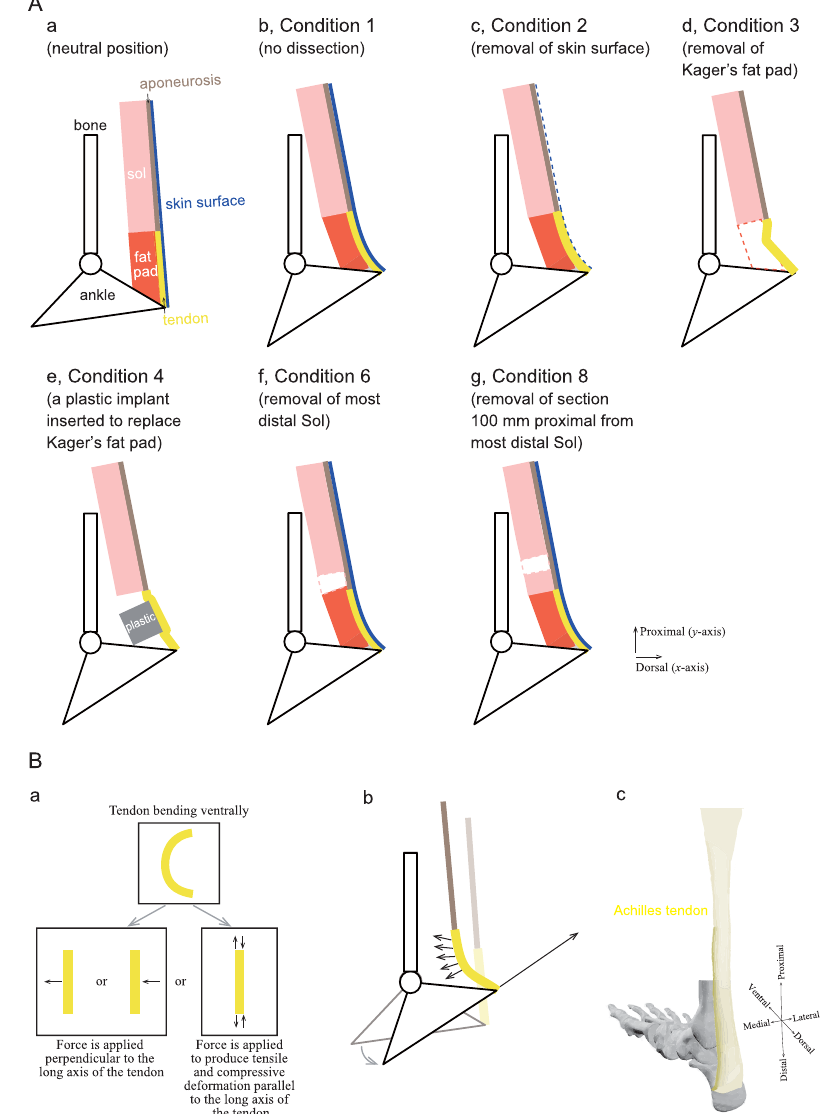
Figure 3. Schematic drawings to illustrate observed tendon bending patterns and a possible mechanism for Achilles tendon bending with passive ankle plantarflexion. ( A ) Diagram representing the observed tendon bending patterns. (a) The ankle is positioned in the neutral position. Red and pink indicate the Kager’s fat pad (fat pad) and soleus (sol) muscle, respectively. The Achilles tendon (tendon) (thick yellow line) is aligned in series with the aponeurosis (light brown line). (b) As the ankle is plantarflexed passively, the Kager’s fat pad constrains tendon movement in the ventral direction, but the skin surface (blue line) also seems to be constrained in the dorsal direction (Condition 1). (c) Even if the skin surface is removed (Condition 2), the magnitude of tendon bending is similar to that of Condition 1. (d), The tendon buckles significantly after removal of the fat pad (Condition 3). (e) Tendon buckling is not observed if a plastic material is implanted in place of the fat pad (Condition 4). (f and g) Removal of the most distal portion of the sol muscle (Condition 6) and the section of the sol muscle 100 mm proximal from the most distal edge of the sol muscle (Condition 8) does not alter the magnitude of tendon bending. ( B ) Schematic illustration of a possible mechanism for Achilles tendon bending. (a) Possible phenomenon of tendon bending in the ventral direction. The tendon will bend if a force is applied perpendicular to the long axis of the tendon or if a force is applied to produce tensile and compressive deformation parallel to the long axis of the tendon. (b) Tendon bending without the Kager’s fat pad, the sol muscle, aponeurosis, or skin surface. As the ankle plantarflexes, the calcaneus moves proximally as well as dorsally. These configurations seem to produce a force on the surrounding tissues and calcaneus. (c) A schematic of the geometrical properties of the Achilles tendon from one cadaver. The image was drawn from medial and posterior views. The length of the Achilles tendon along the proximodistal axis is long while the width along the mediolateral axis is narrow. Such geometrical properties provide lower flexural stiffness (i.e., deformable) in the dorsoventral direction rather than in the mediolateral